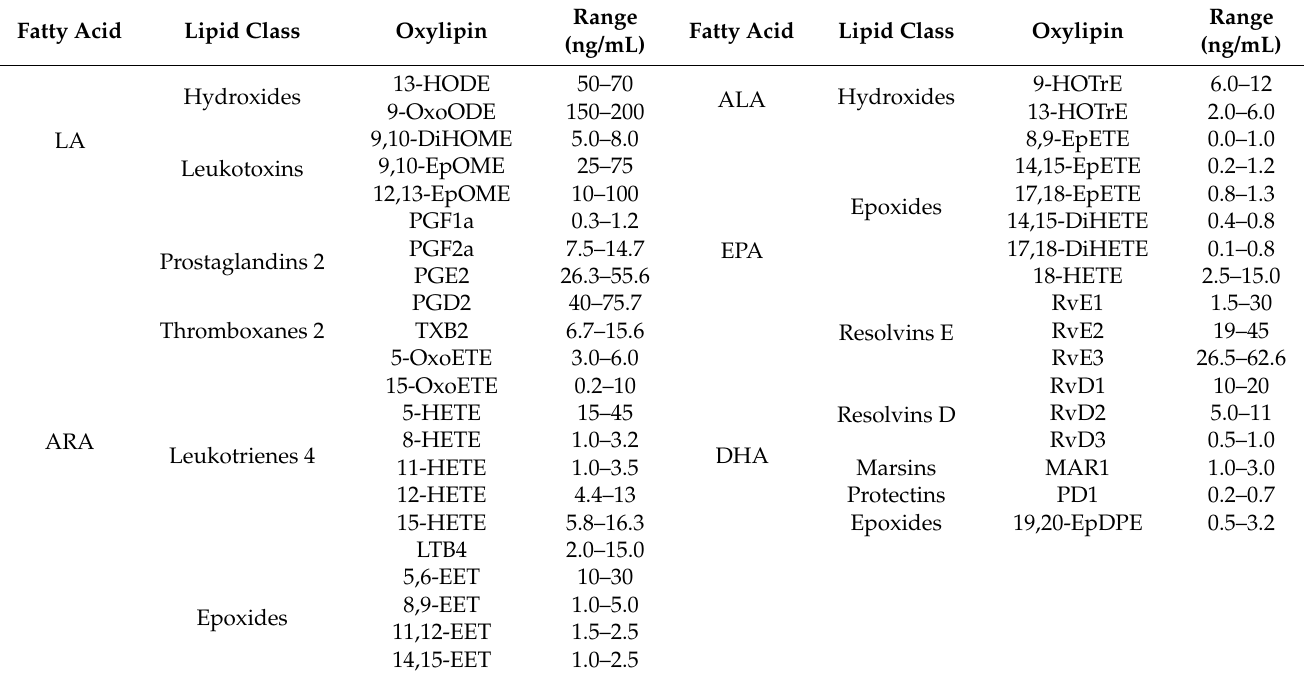
Table 1. Levels of oxylipins found in breast